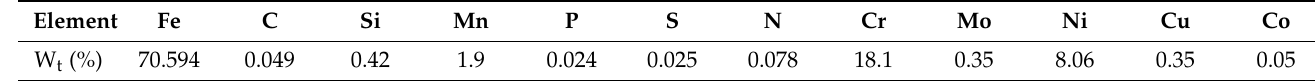
Table 1. Chemical composition of SS304.